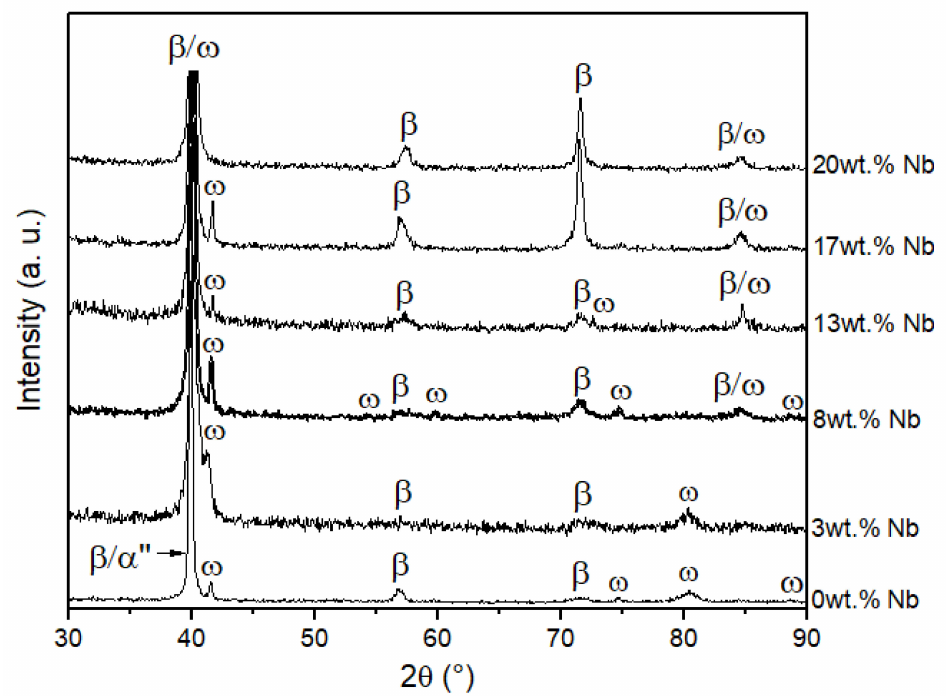
Figure 1. X-ray diffraction pattern of Ti–12Mo– x Nb ( x = 0, 3, 8, 13, 17, and 20) alloys treated at 950 ◦ C/1 h. The diffractogram shows the presence of α (cid:48)(cid:48) and ω martensitic phases in the β matrix for the Ti–12Mo alloy. With Nb addition, the α (cid:48)(cid:48) phase was inhibited, forming only the ω phase in matrix β